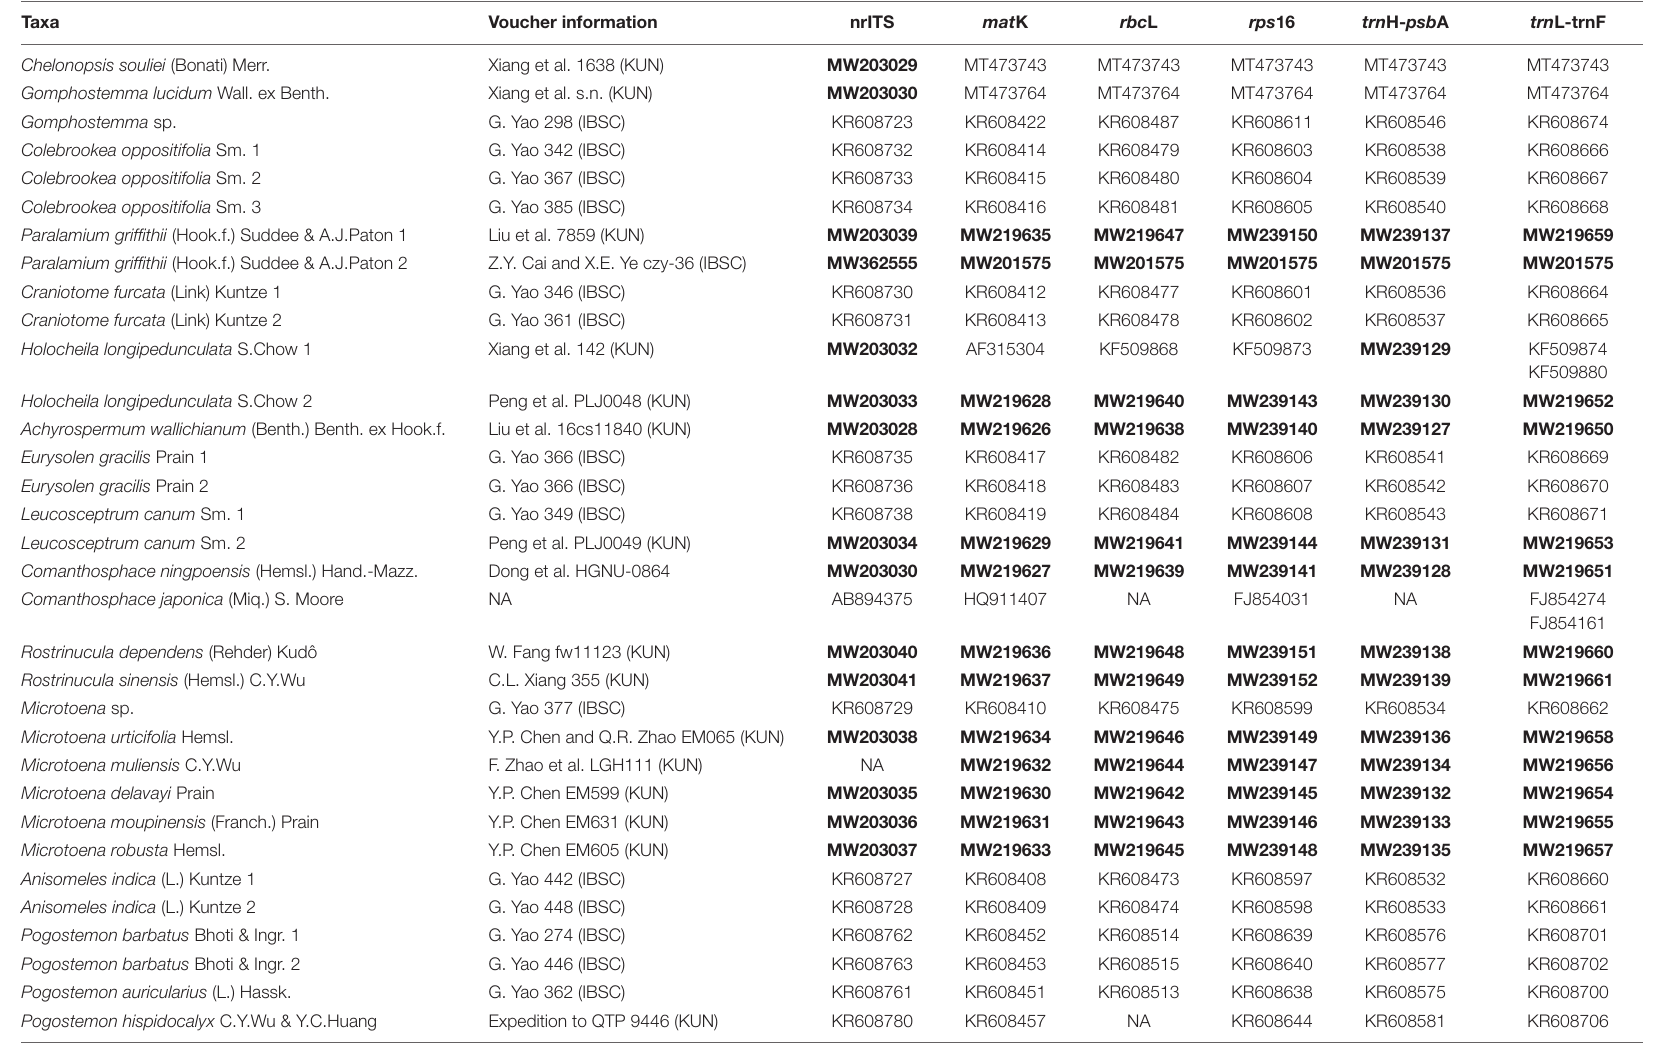
TABLE 1 | The voucher information of the taxa from Tribe Pogostemoneae analysis in this study, the GenBank accession numbers of the new sequenced are shown in the bold, other sequence were from the previous studies (NA = not